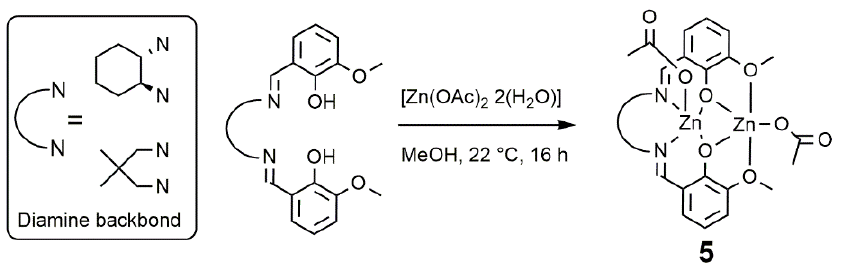
Figure 3. Synthesis of dinuclear zinc complex 5 by Williams et al. Reproduced with modification and permission from ref [26]. Copyright (2015) American Chemical Society.